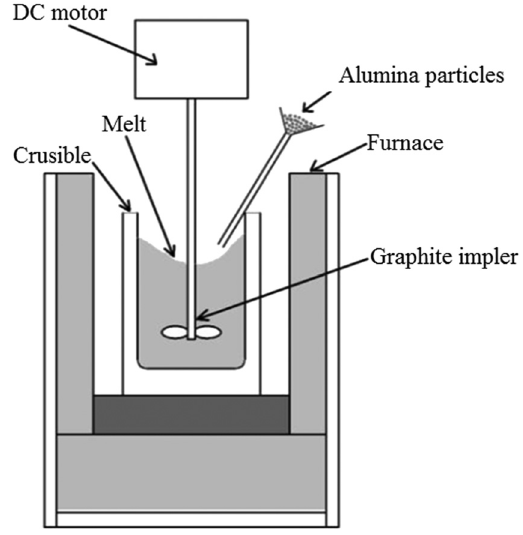
Figure 1: Diagram of the experimental setup secondhand in making of the cast Al/Al 2 O 3